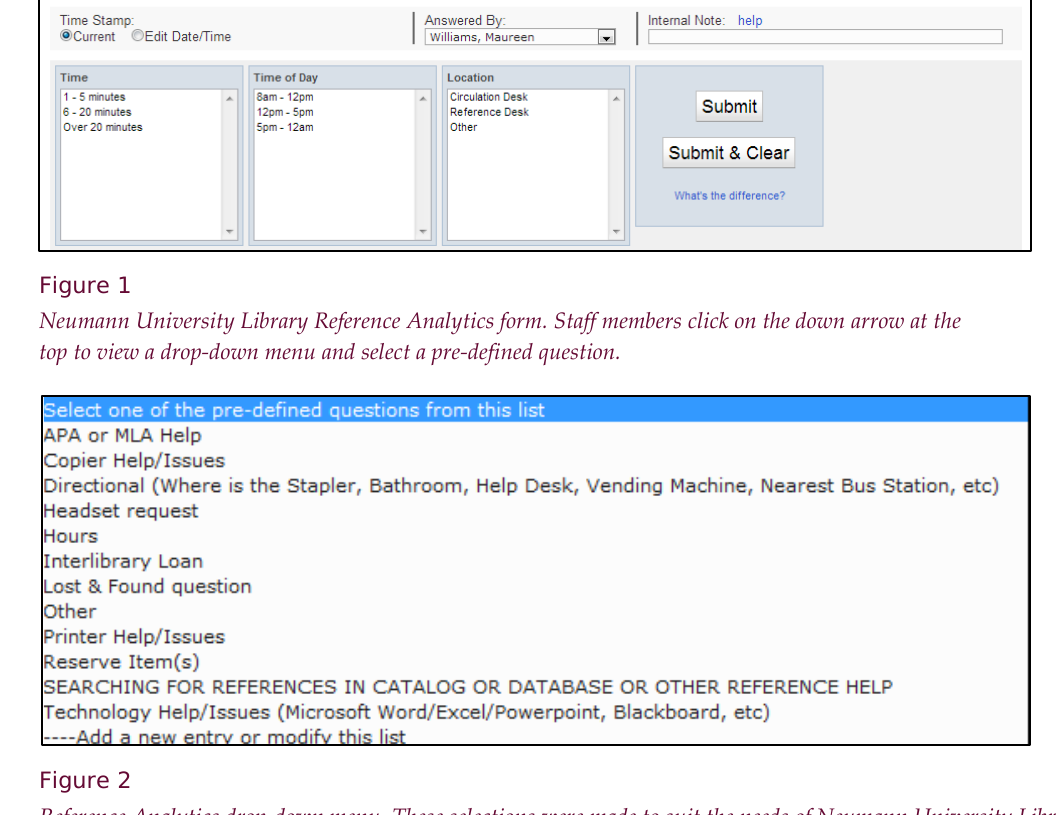
Reference Analytics drop-down menu. These selections were made to suit the needs of Neumann University